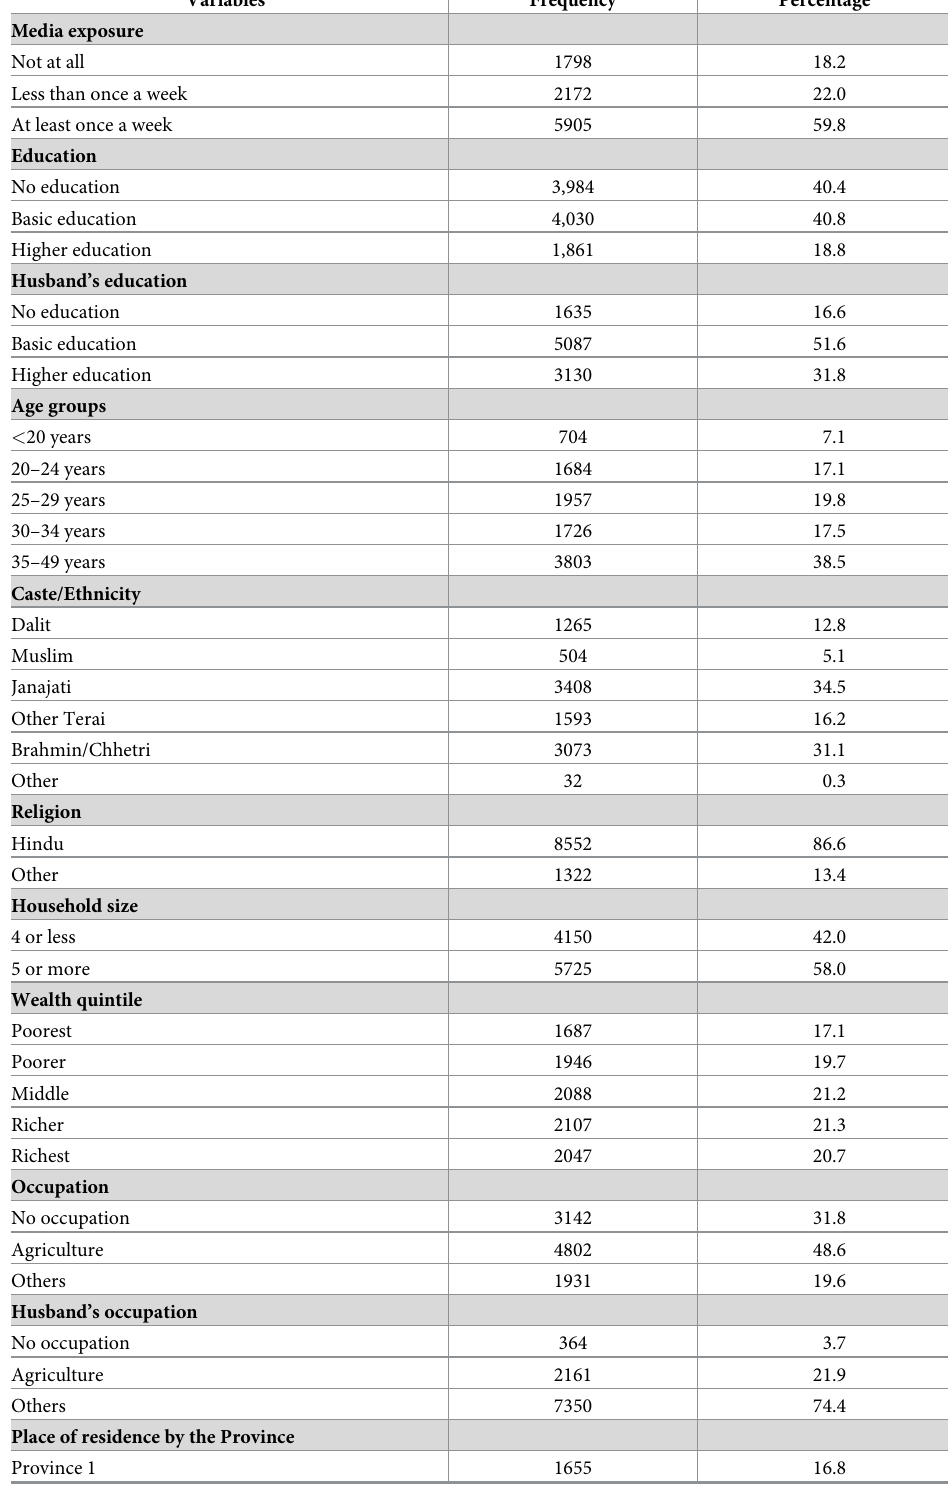
Table 4. Demographic variables of the study